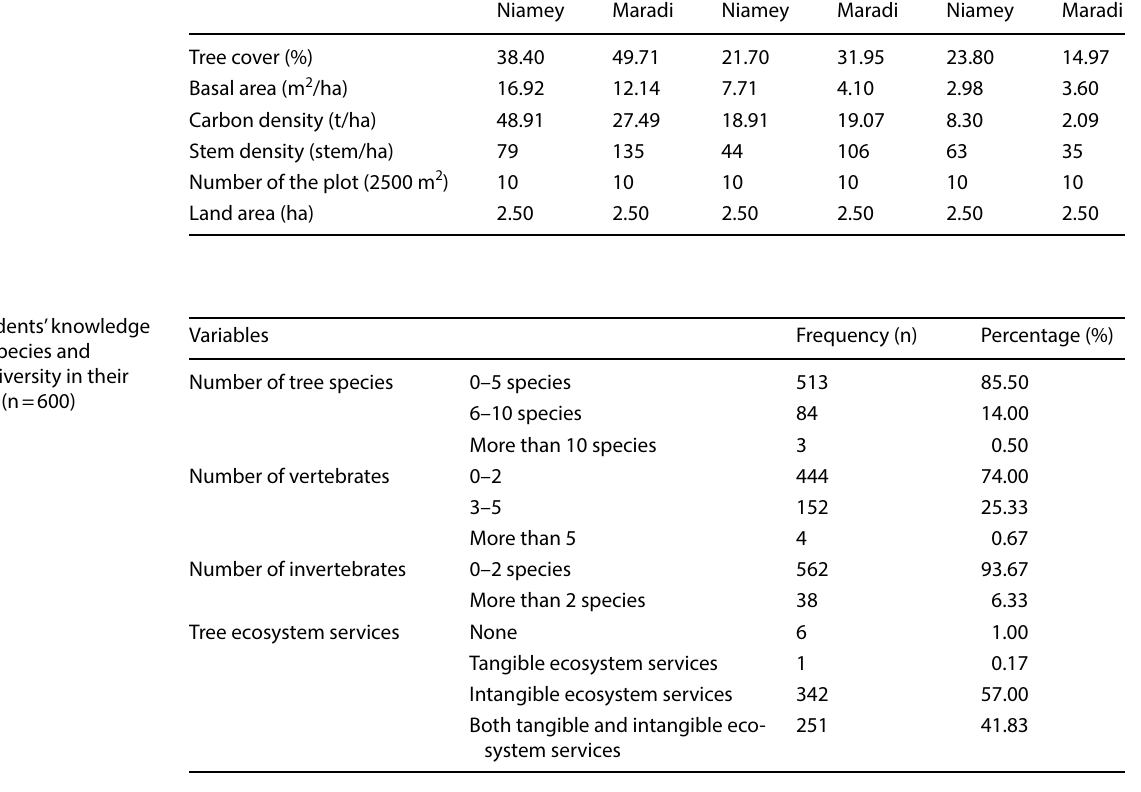
Table 3 Parameters of the structure of urban forest in the schoolyards of Maradi and Niamey